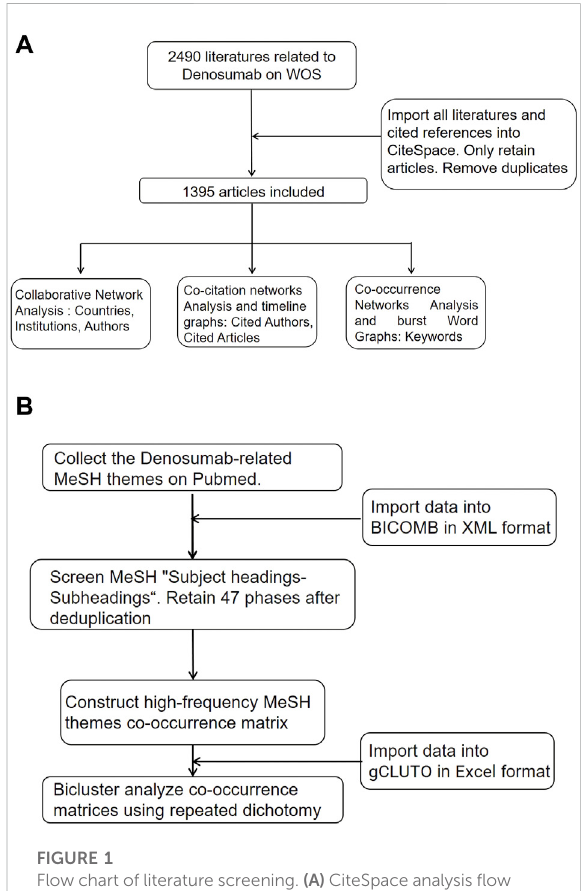
FIGURE 1 Flow chart of literature screening. (A) CiteSpace analysis fl ow chart. (B) MeSH themes biclustering analysis fl ow chart.